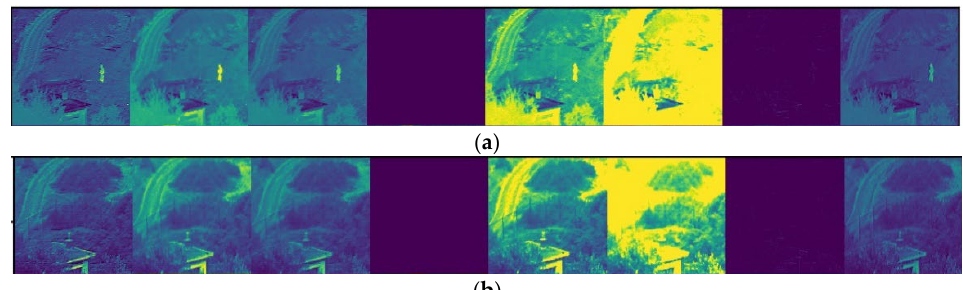
Figure 5. Outputs of the first eight convolution layers of the encoder on an IR image and the corresponding visible image. ( a ) IR; ( b ) visible. Input images are from TNO [28] .